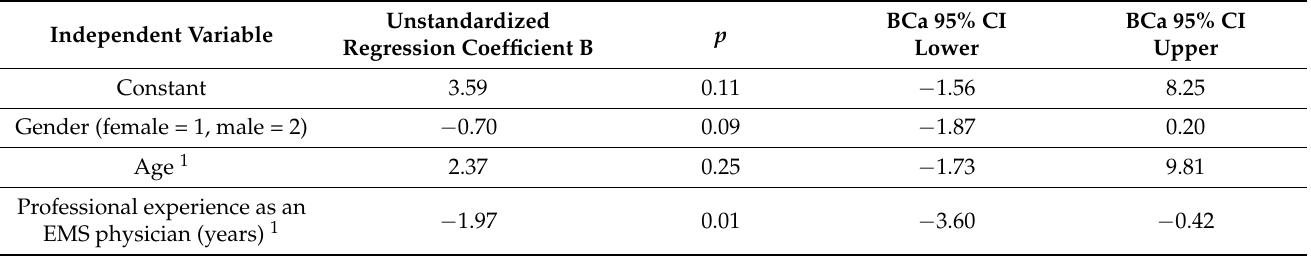
Table 3. Impact of demographic variables and professional experience as an EMS physician on symptom load. Results of multiple linear regression.